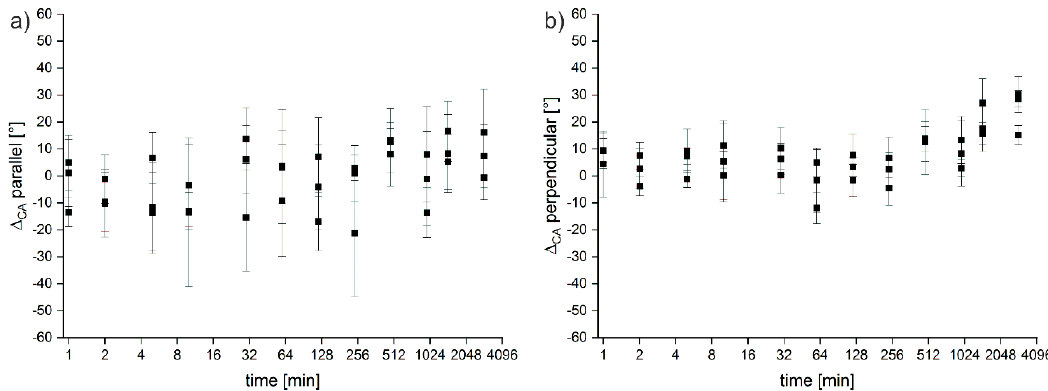
Figure 7. Changes in the CA (Δ CA ) on PLA after treatment with 1.0 mol/L NaOH for different times. ( a ) Δ CA parallel to the printing direction, ( b ) Δ CA perpendicular to the printing direction. Data (not shown) for the other materials and treatments are very similar. Note the Log2 scale of the x-axis chosen for better clarity of representation.